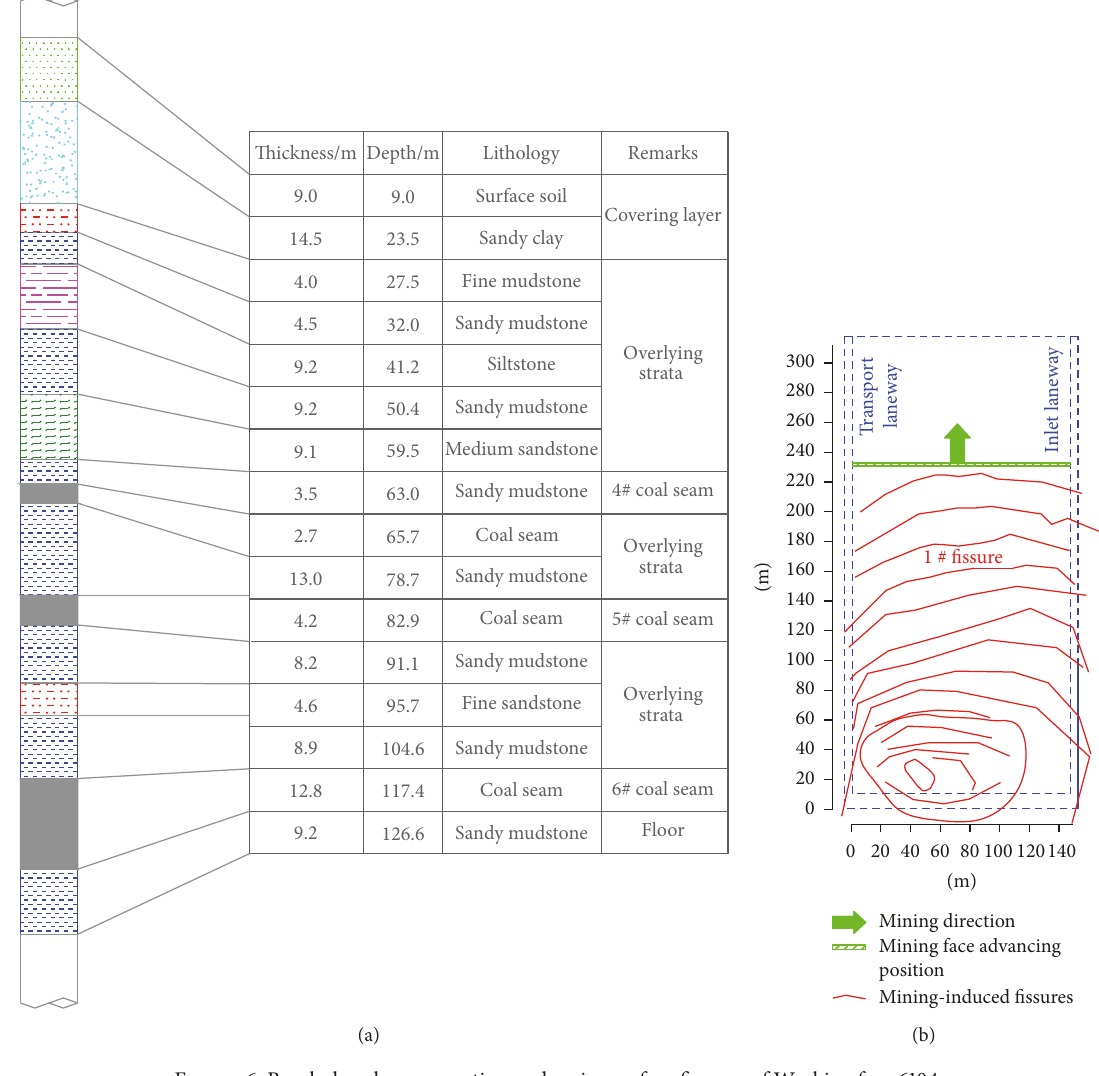
Figure 6: Borehole columnar section and major surface fissures of Working face